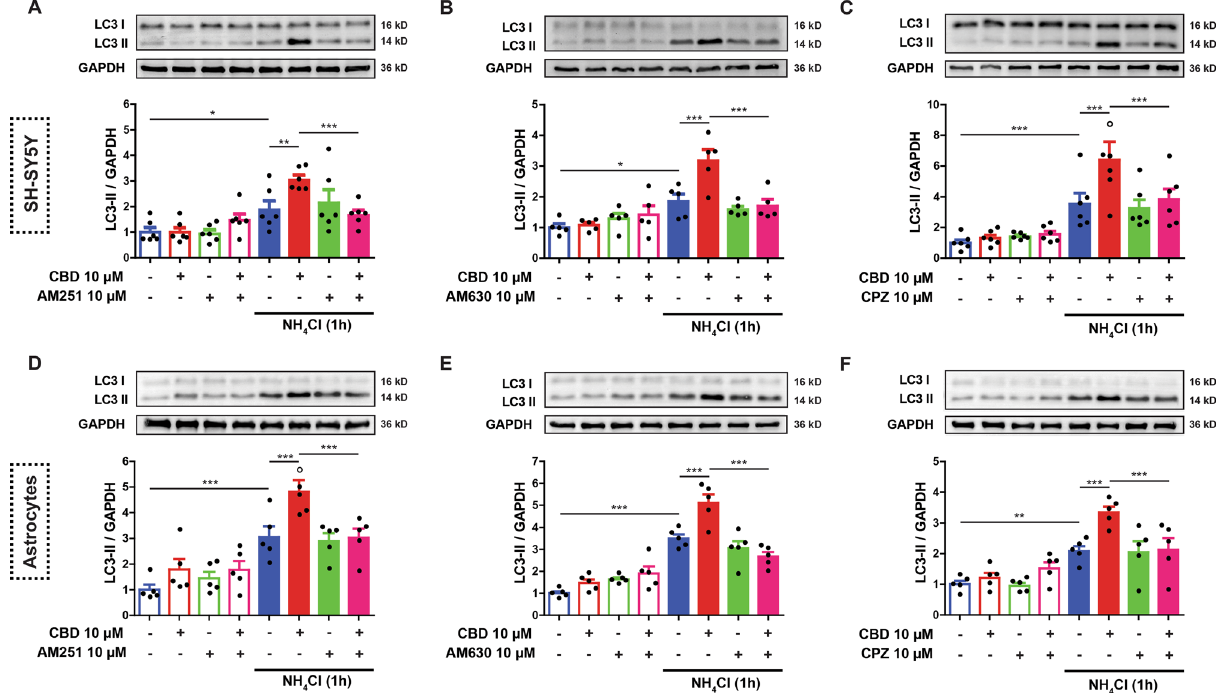
Figure 3. CBD-induced autophagy by CB1, CB2 and TRPV1 receptor activation in neural cells. The autophagic flux was evaluated in SH-SY5Y and murine astrocyte cells after 2 h of treatment with 10 µM CBD and/or with pre-treatment (30 min) with the respective CB1, CB2 and TRPV1 antagonists, AM 251, AM 630 and capsazepine (CPZ) (10 µM each), in the presence or absence of the lysosome inhibitor NH 4 Cl, added during the last hour of treatment. CBD potentiated LC3-II levels under NH 4 Cl blockade, which was reverted by AM 251, AM 630 and CPZ pre-treatment in both SH-SY5Y (A-C) and murine astrocyte (D-F) cells. Samples